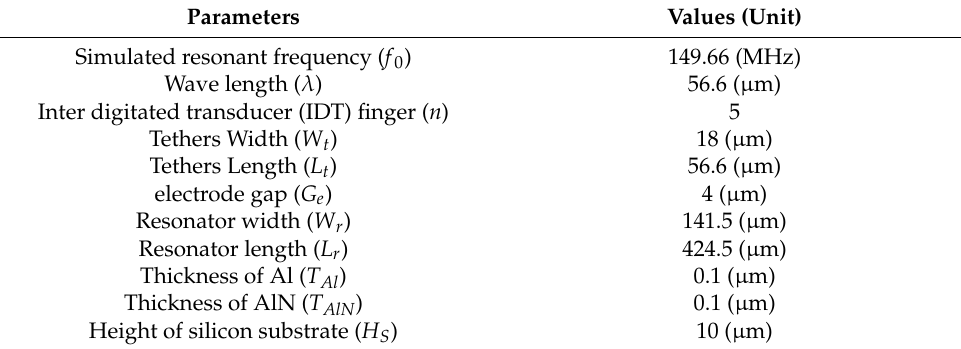
Figure 8. Simulation diagrams of quarter piezoelectric MEMS resonators: ( a ) traditional type piezo ‐ electric MEMS resonator; ( b ) piezoelectric MEMS resonator with 4 × 7 SCC ‐ PnC array plate.